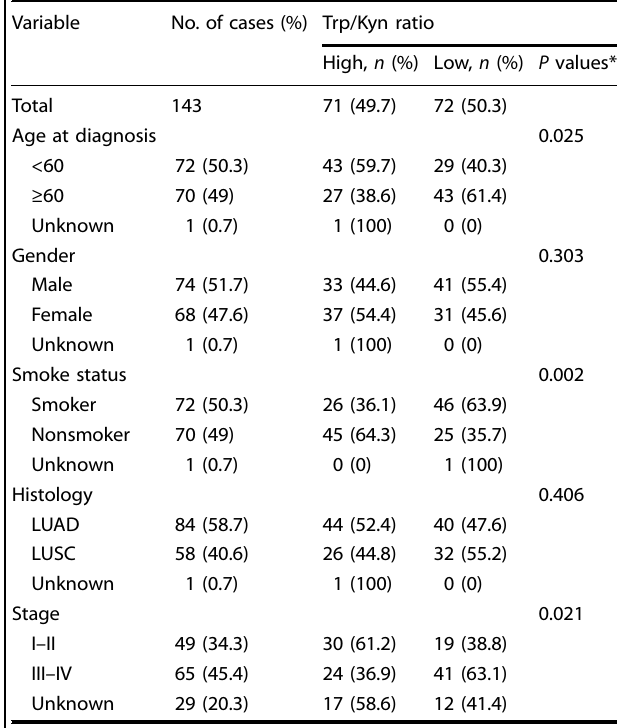
Table 1. Baseline demographic characteristics of the 143 NSCLC